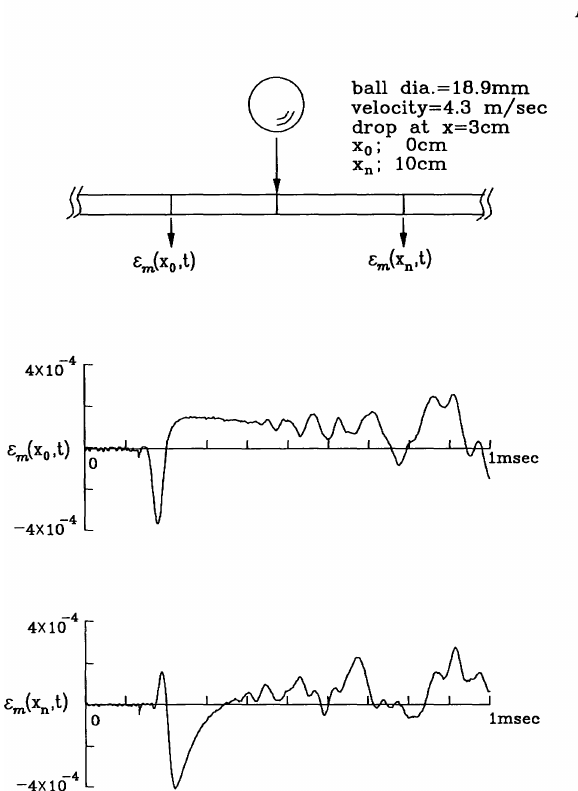
FIGURE 14 Test result of steel ball drop. (a) Config uration of drop test; (b) strain at Xo = 0 cm; (c) strain at Xn = 10 cm.